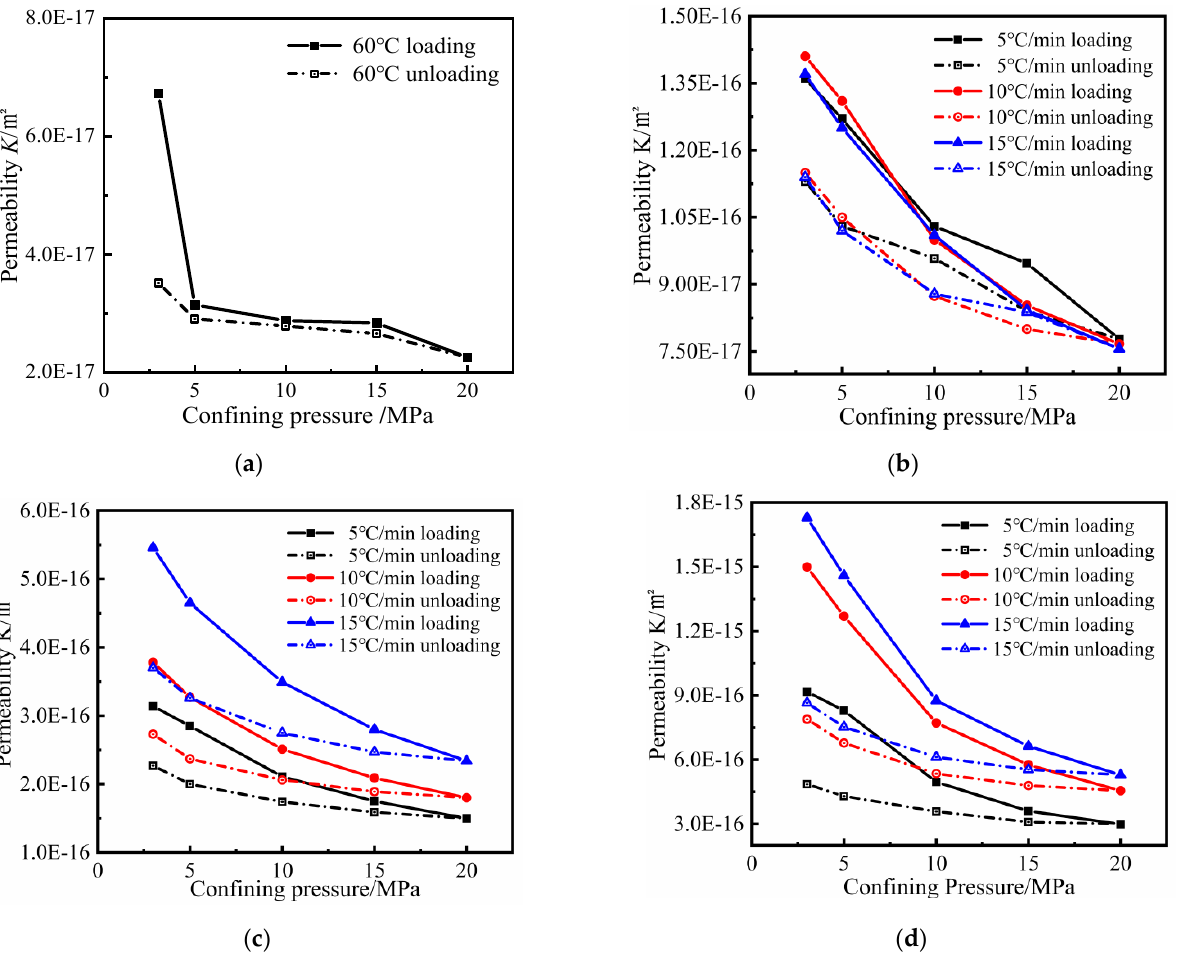
Figure 5. Variation in gas permeability under confining pressure loading and unloading: ( a ) 60 °C; ( b ) 400 °C; ( c ) 500 °C; ( d ) 600 °C.